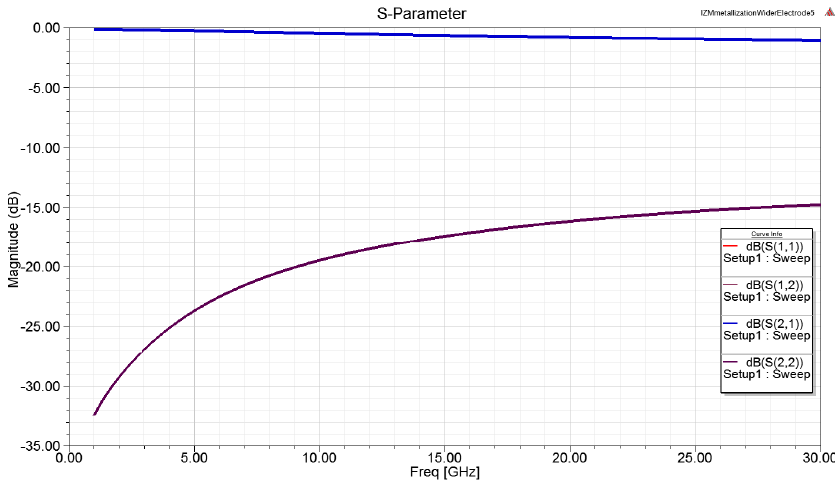
Figure 18. S-parameter simulation of the modulator